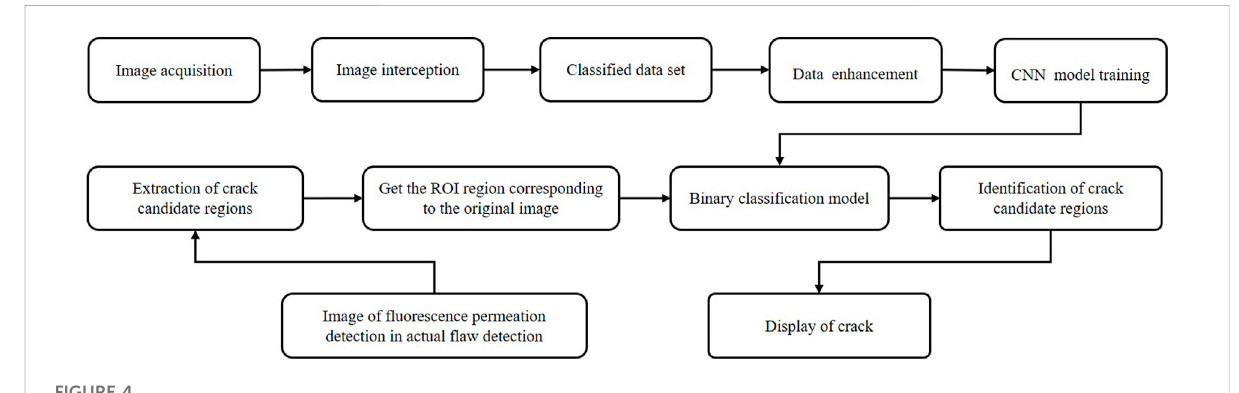
FIGURE 4 Our method fl ow chart